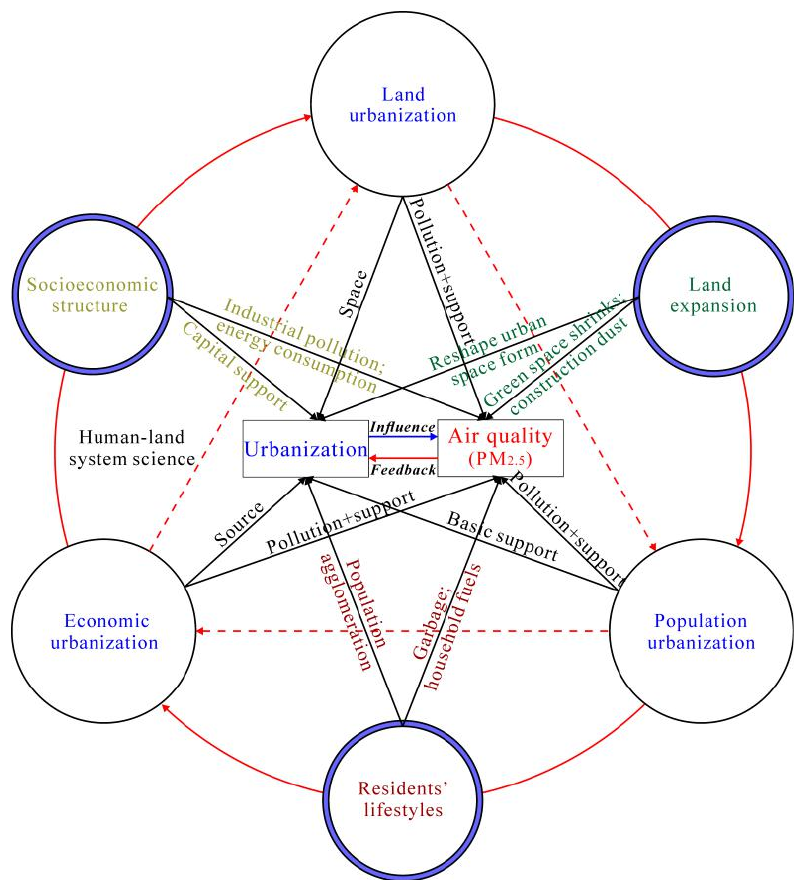
Figure 10. Influence mechanism of urbanization system on PM 2.5 concentrations.